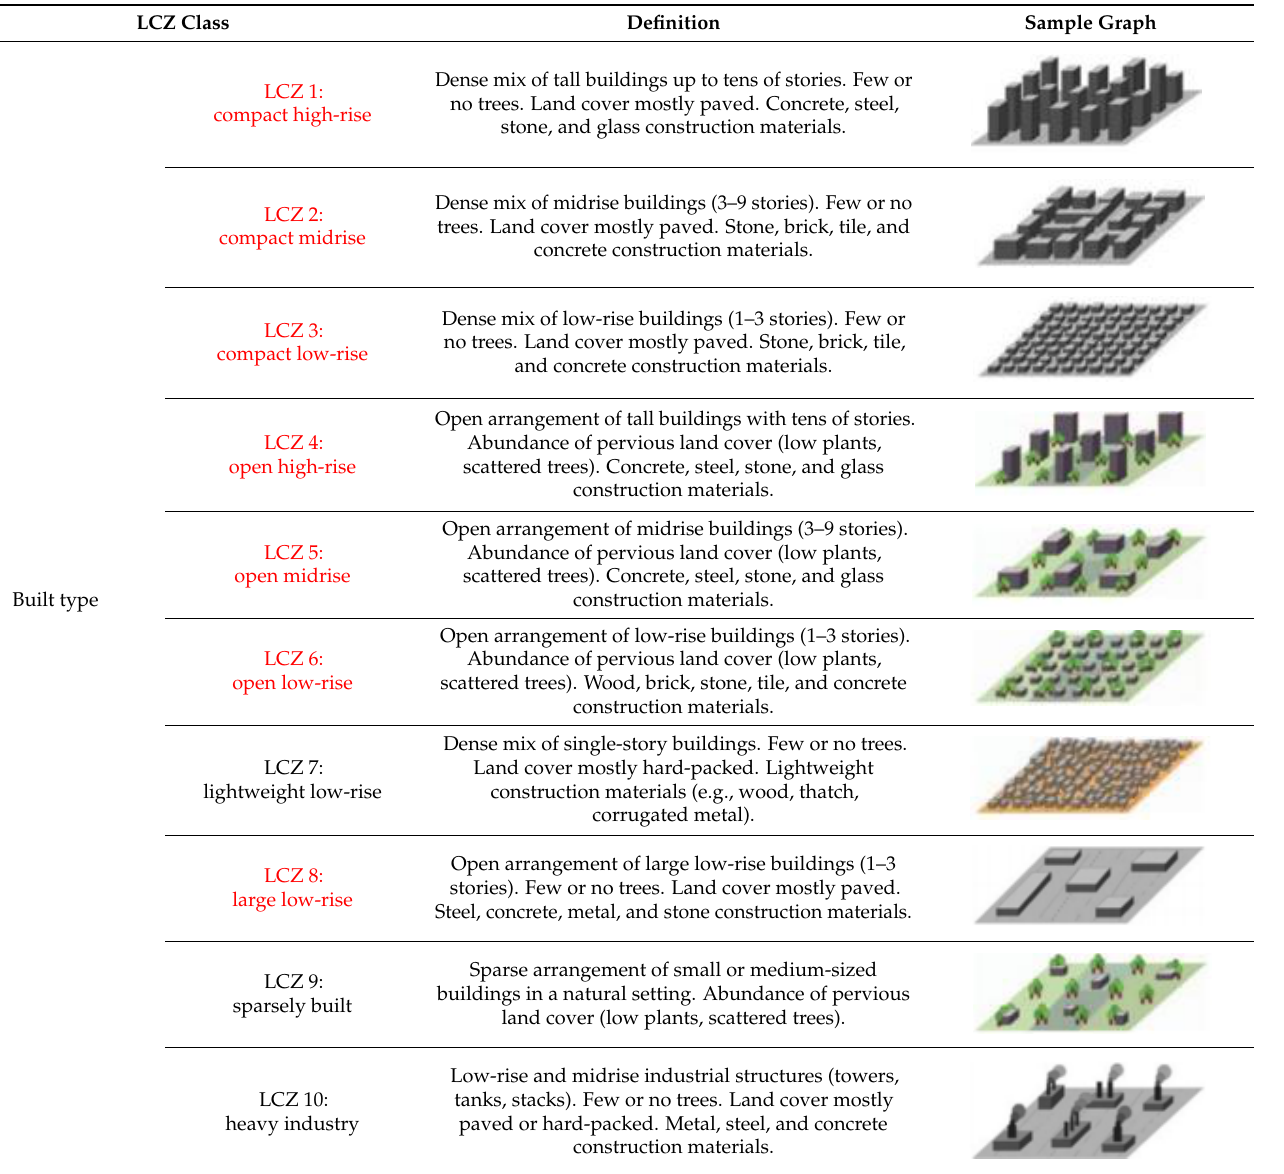
Table 1. The LCZ classification scheme Table 1. The LCZ classification scheme [22]. Table 1. The LCZ classification scheme [22]. Table 1. The LCZ classification scheme [22]. Table 1. The LCZ classification scheme [22]. Table 1. The LCZ classification scheme [22]. Table 1. The LCZ classification scheme [22]. Table 1. The LCZ classification scheme [22]. Table 1. The LCZ classification scheme [22]. Table 1. The LCZ classification scheme [22].